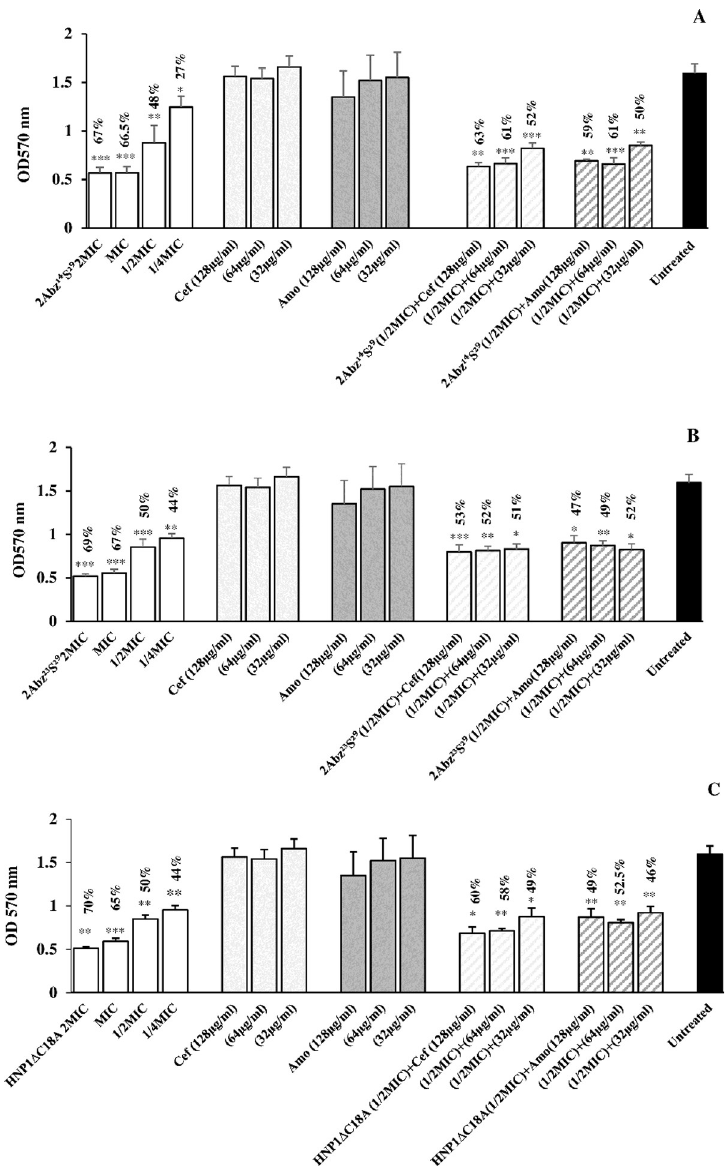
Fig 5. Biofilm eradication by individual antimicrobial peptides (2Abz 14 S 29 , 2Abz 23 S 29 , and HNP1 Δ C18A), antibiotics (Cefixime and Amoxicillin) or their combination are shown in panels A, B, and C. Untreated bar indicates E . coli biofilm without any antimicrobial agent. Data show the means ± SD of three independent experiments. An asterisk indicates the statistically significant difference between antimicrobial agent and untreated control as measured by Student’s t-test ( � p < 0.05, �� p < 0.01 and ��� p < 0.001). Percent numbers indicate % reduction of